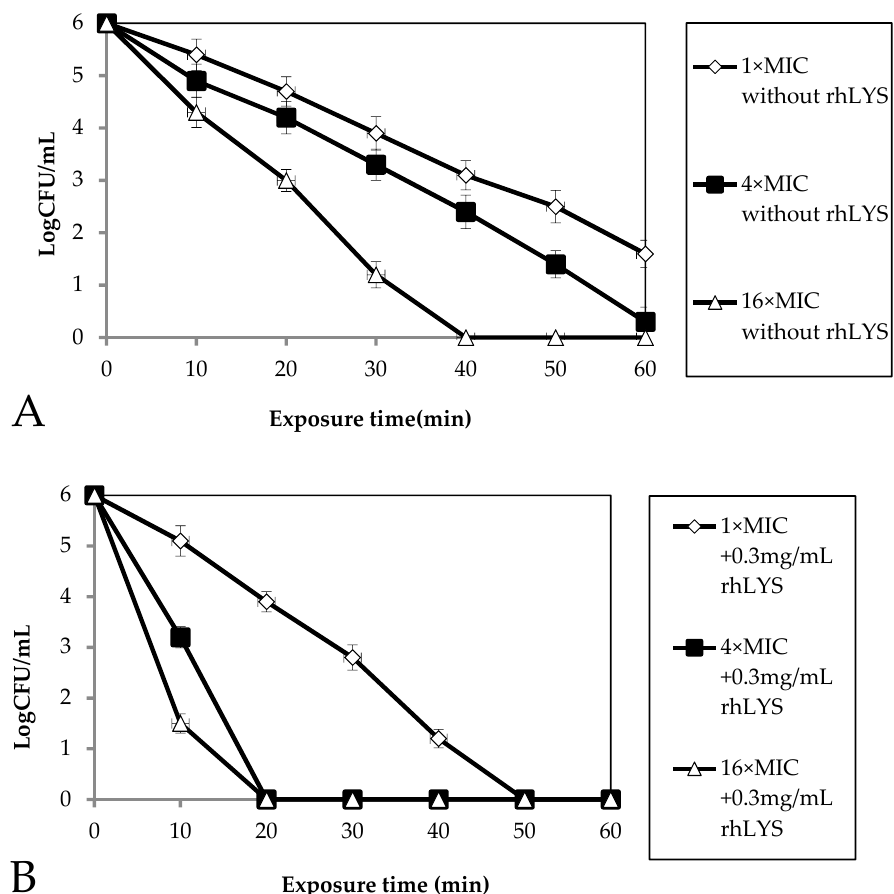
Figure 5. Bactericidal kinetics. The bactericidal kinetics of metronidazole without hLYS ( A ) and of metronidazole with 0.3 mg/mL hLYS ( B ) against H. pylori were monitored at 10 min intervals for 1 h at 37 °C. Subsequently, aliquots were diluted (serial 10-fold dilutions) and plated for CFU counts after 72 h incubation at 37 °C.